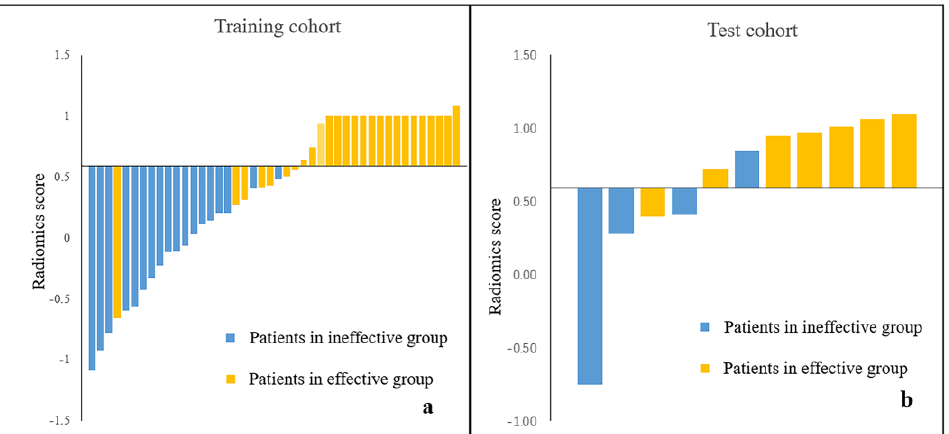
Figure 5. Waterfall plots of the radiomics scores of PAH patients. ( a ) Radiomics scores in PAH patients with different therapeutic effect in training cohort. ( b ) Radiomics scores in PAH patients with different therapeutic effect in test cohort.